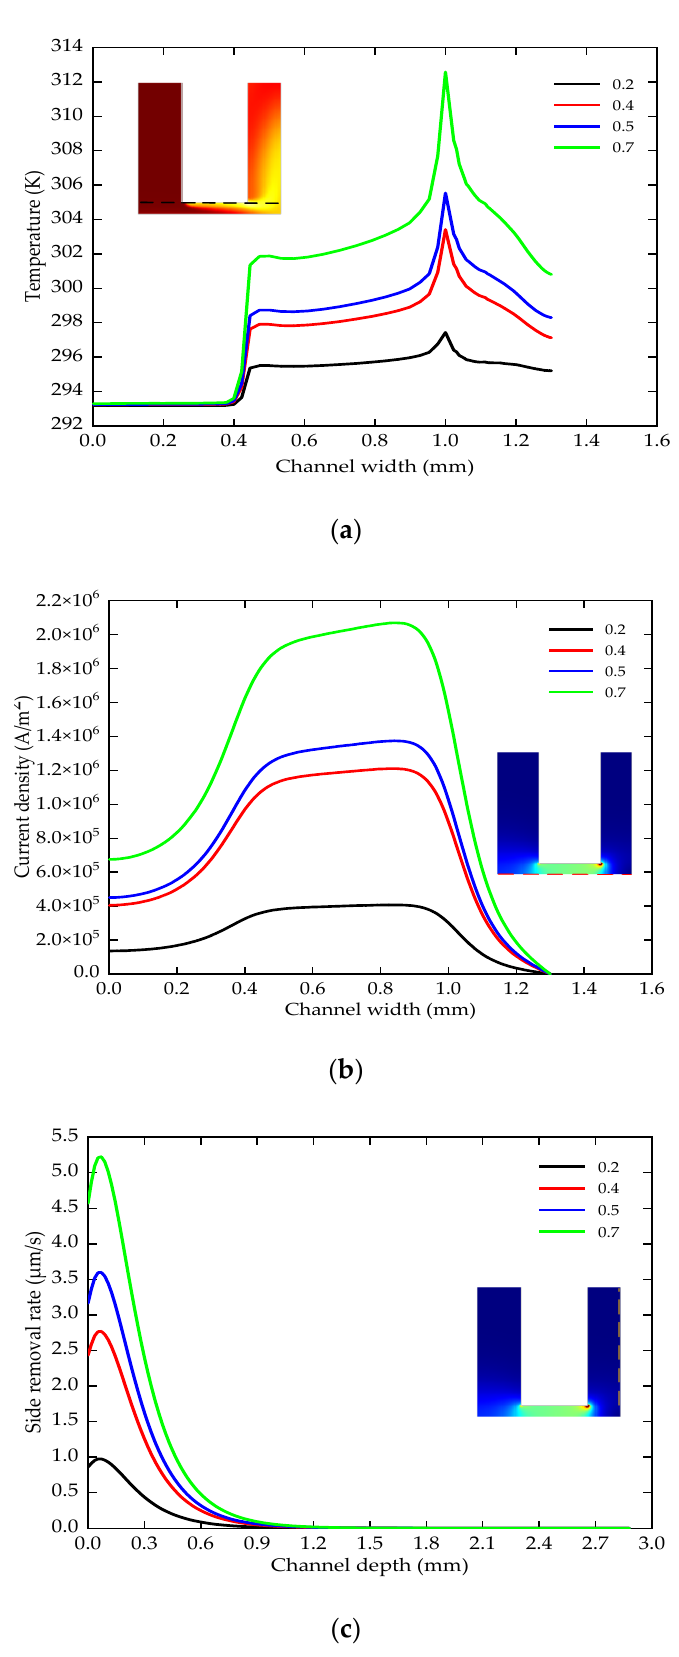
Figure 9. The temperature, current density and side removal rate of various duty ratios; ( a ) the change of the temperature; ( b ) the change of the current density; ( c ) the change of the side removal rate.